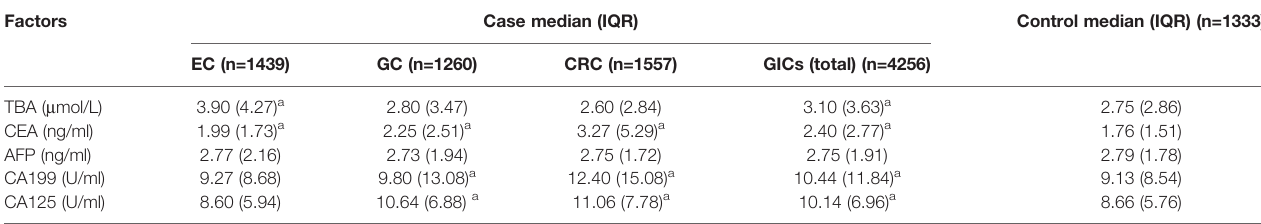
TABLE 2 | TBA and tumor markers among patients and control individuals.